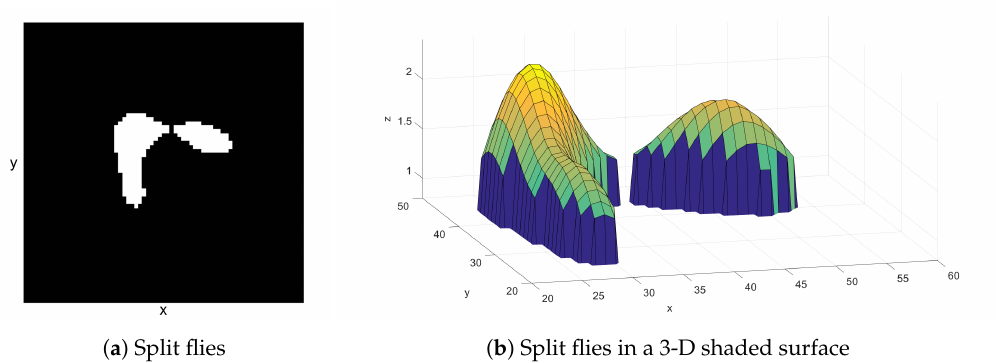
Figure 5. ( a ) Split flies in a 2-D scene and ( b ) in a 3-D shaded surface. The merging flies blob from Figure 4 was split by varying threshold values until the blob is split into an expected number of